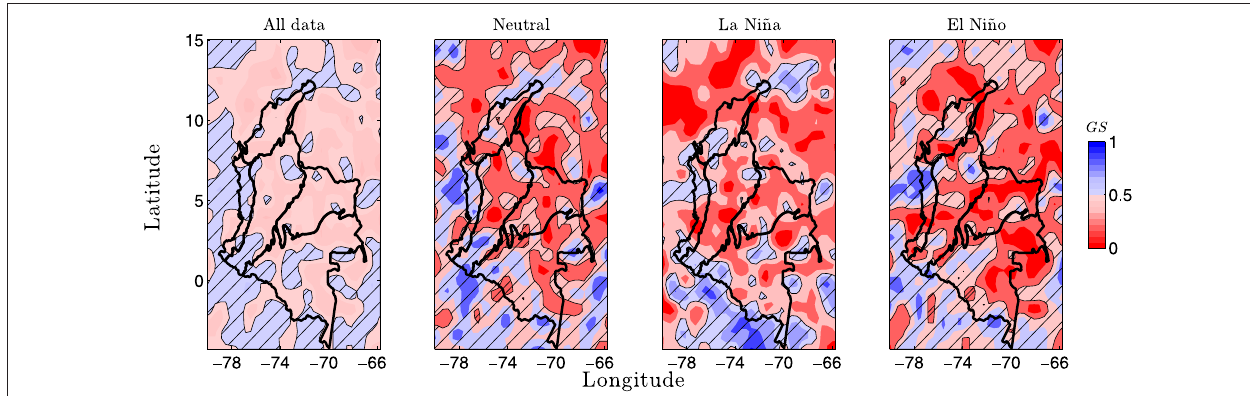
FIGURE 13 | Generalized synchronization index between the moisture advection by the cross-equatorial flow and rainfall anomalies. Dataset No. 1, period 1975–2006. The hatched contours indicate zones where the GS is significant at 5%.